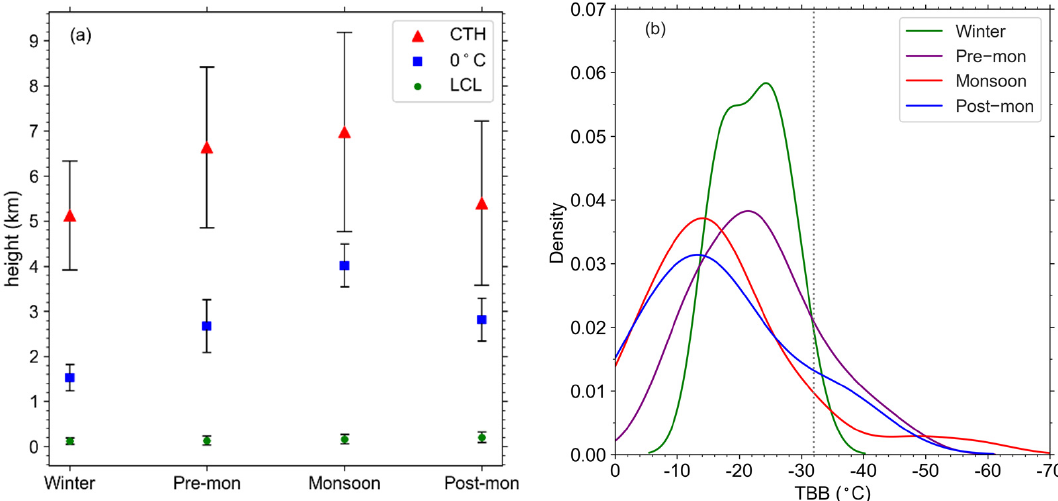
Figure 13. The lifting condensation level (LCL), 0 °C isotherm layer height, cloud top height (CTH) and standard deviation ( a ). TBB probability density function ( b ). The dashed line in Figure 13b denotes the TBB temperature of − 32 °C.